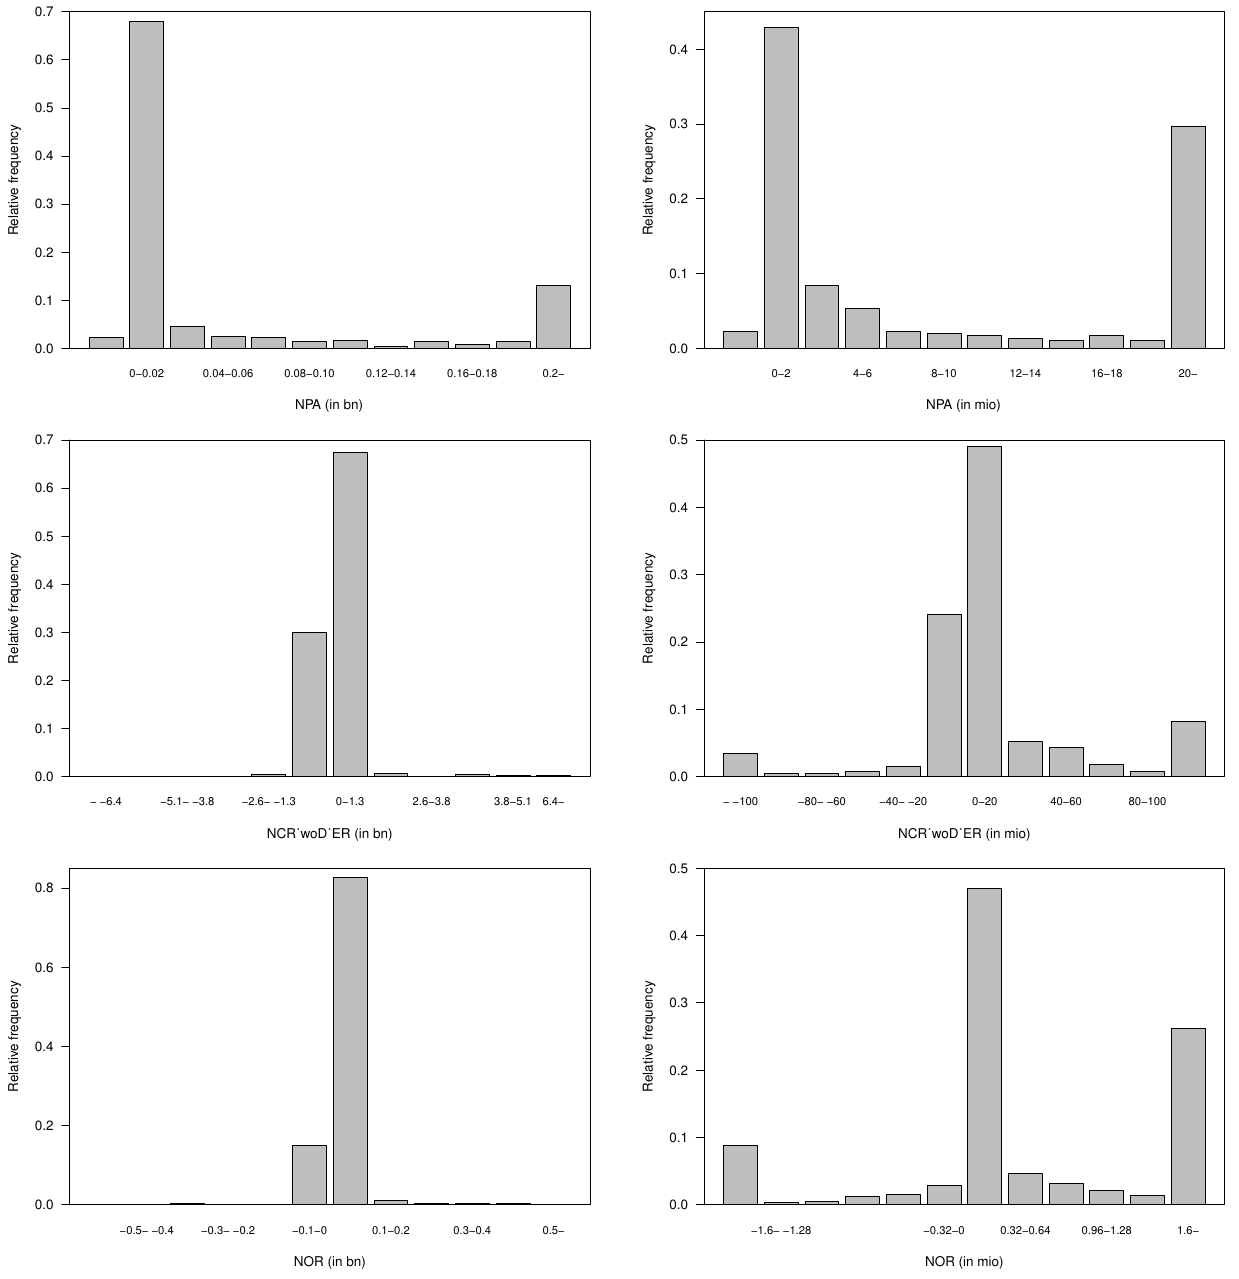
Figure A3. Relative frequency of the insurance cost for reinsurance undertakings: net claims pay- ments ( NPA ), net change in claim reserves without change in ER ( NCR _ woD _ ER ) and net change in other technical reserves ( NOR ). The figure presents twice the relative frequency of the NPA , NCR _ woD _ ER and NOR : once sliced by billion and once sliced by million, whereby the last band includes all remaining higher